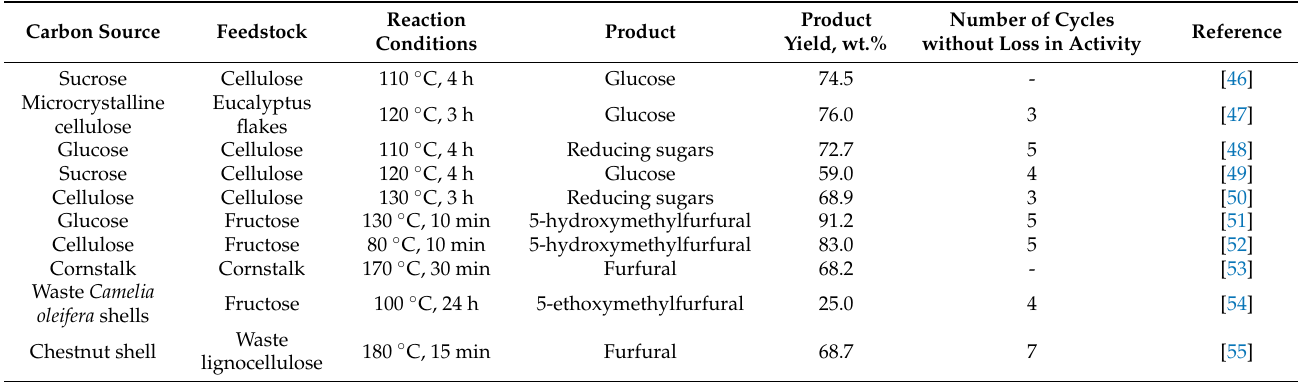
Table 3. Sulfonated carbon-based catalysts for biomass conversion.